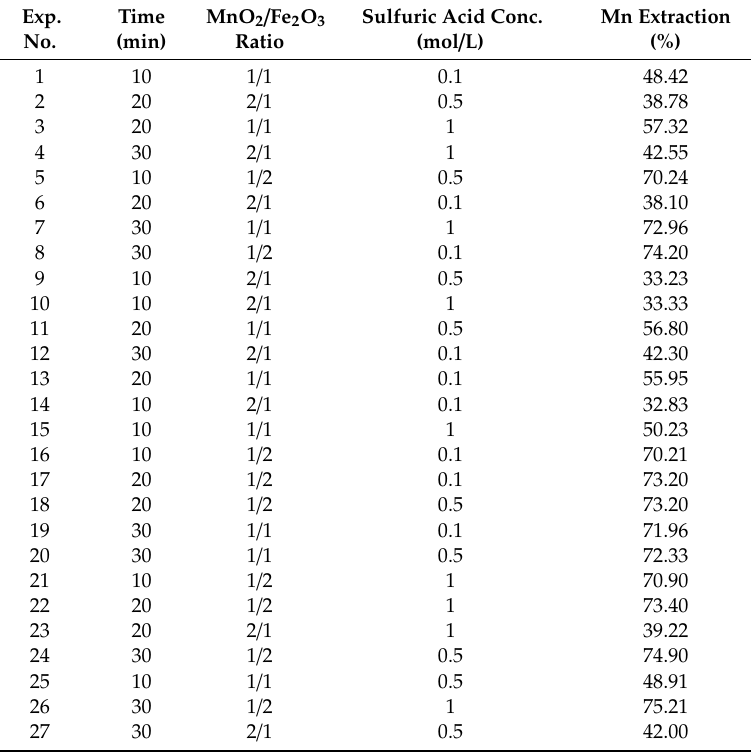
Table 3. Experimental configuration and Mn